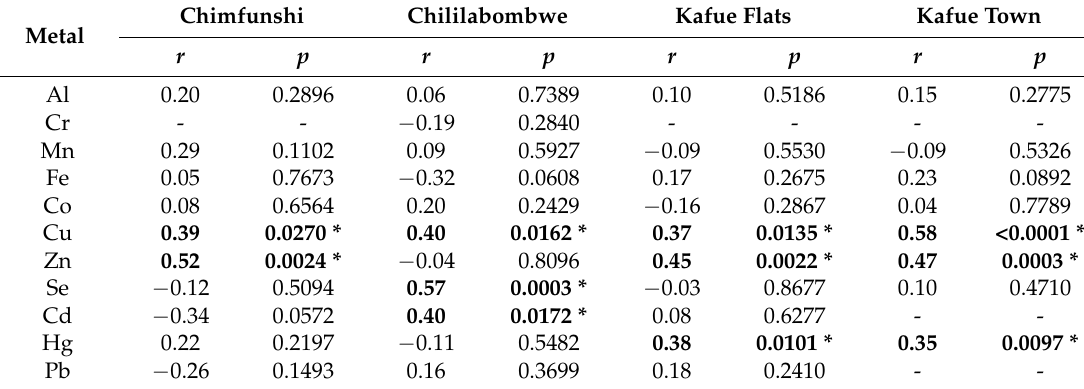
Table 3. Pearson correlation coefficients ( r ) and p -values for correlation between cgMT expression levels and heavy metals in liver tissue of 155 C. gariepinus fish collected over three seasons, conducted separately for each of four